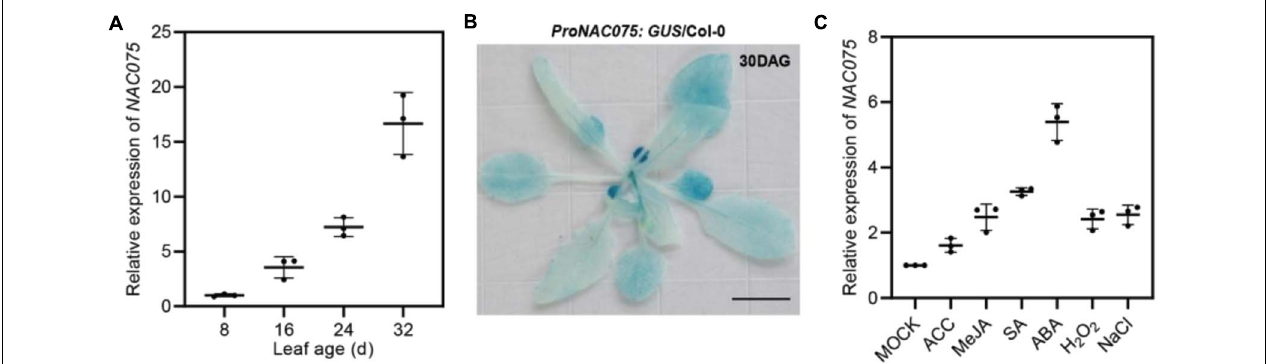
FIGURE 1 | NAC075 transcription factor is a senescence-associated gene that is induced by age, plant hormones, ROS, and salinity. (A) qRT-PCR analyses of NAC075 expression in the third or fourth rosette leaves at the indicated leaf age. Data are represented as means ± SD ( n = 3). (B) GUS staining of rosette leaves